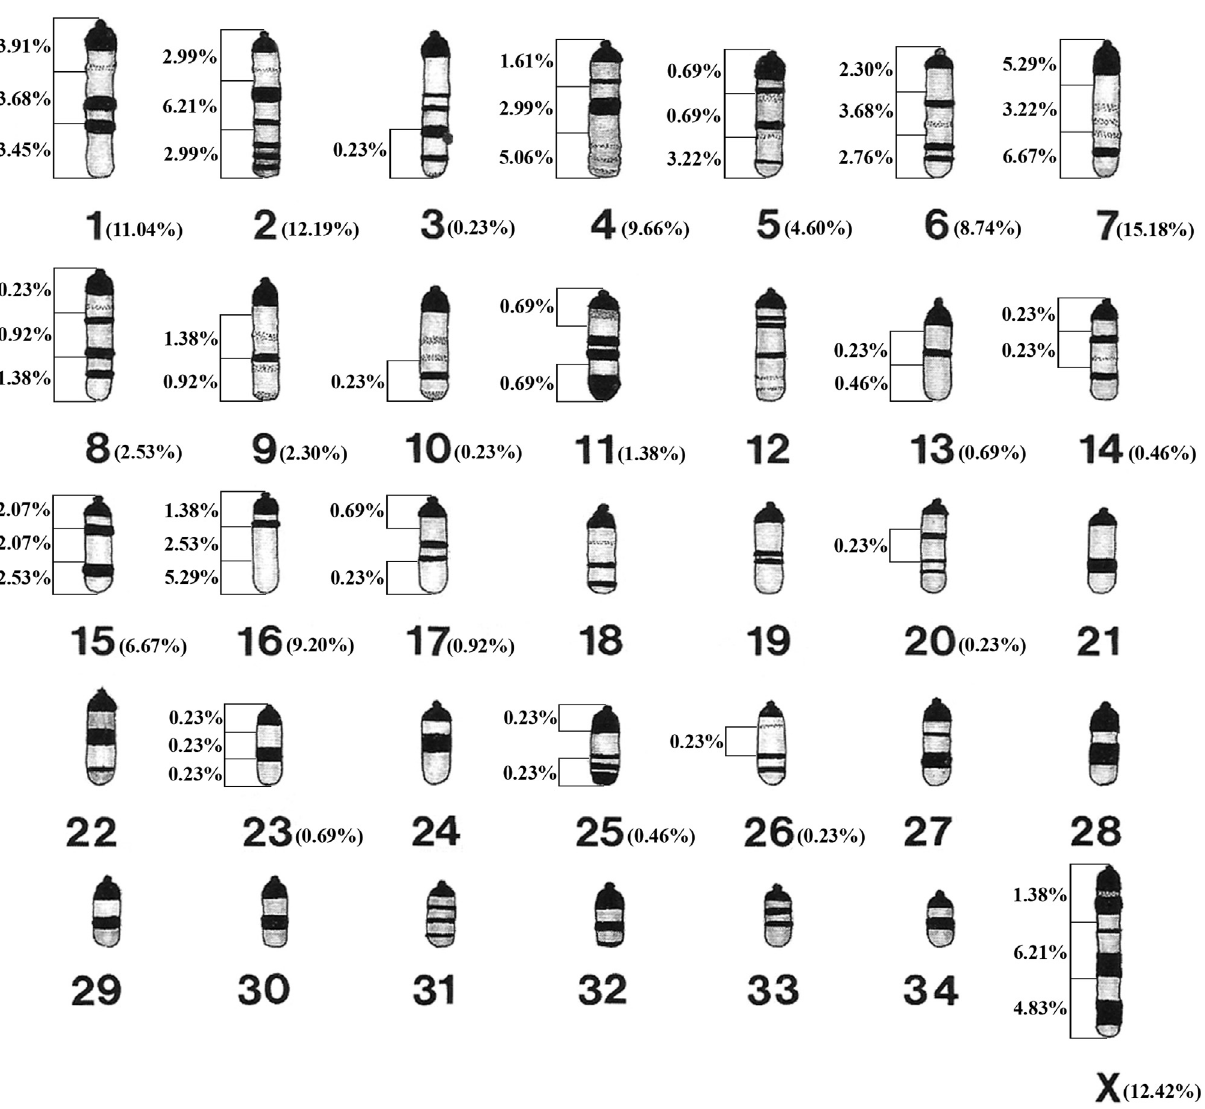
Figure 3 - Idiogram of the G-banding pattern of Mazama gouazoubira chromosomes, indicating the location and frequency of chromosomal aberrations induced by doxorubicin in each pair and each chromosomal region. Idiogram proposed by Neitzel (1987), with